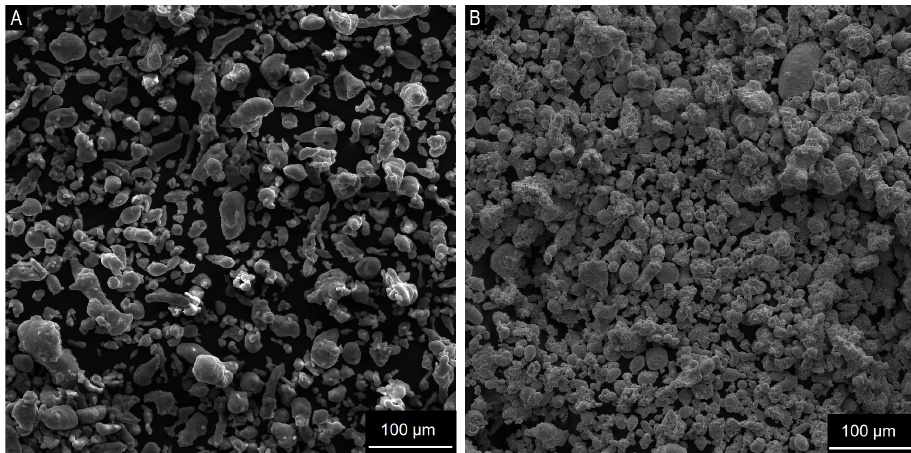
Figure 2. SEM images of the aluminum (A) and copper (B) powders.